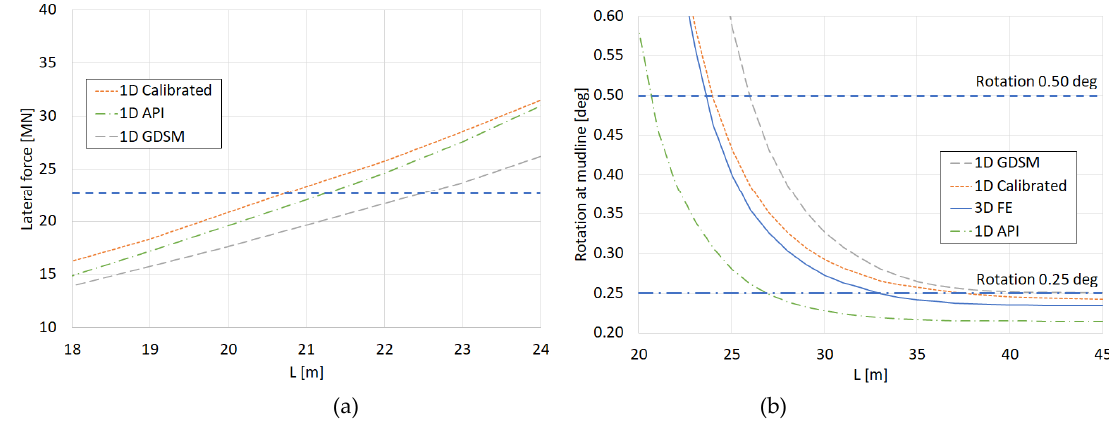
Figure 7. Embedded length analysis. ( a ) Bearing capacity as a function of embedment depth L considering Ultimate Limit State (ULS) conditions. ( b ) Pile rotation as a function of embedment depth L considering Serviceability Limit State (SLS) conditions.